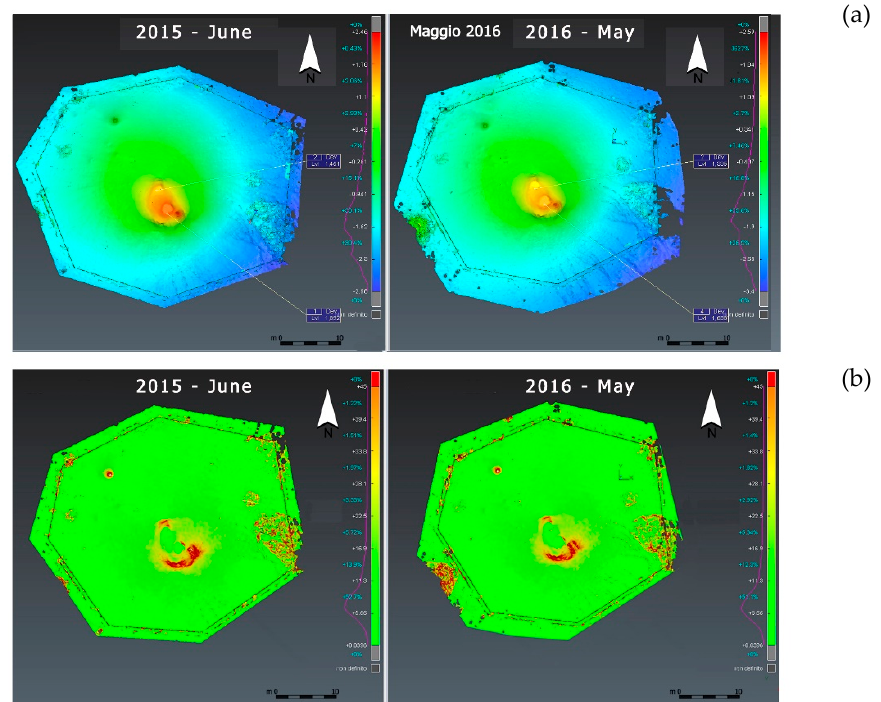
Figure 8. Levelness ( a ) andDigital Elevation Models ( b ) comparison of the terrain of Area 1 derived from terrestrial laser scanning data.